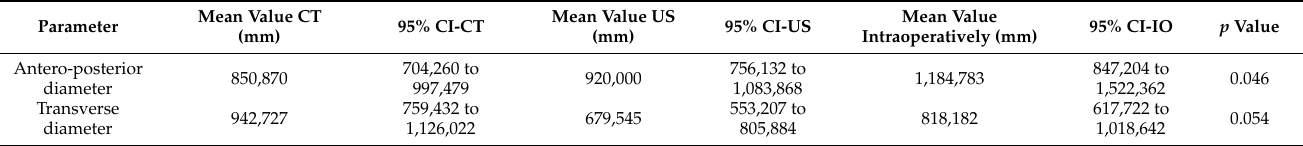
Table 1. Comparison between antero-posterior and transvers diameter using US and CT.